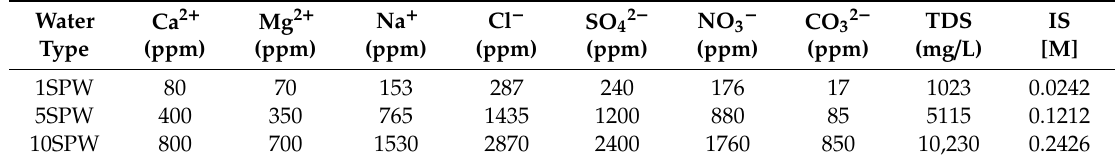
Table 1. Synthetic plant water types and their ion